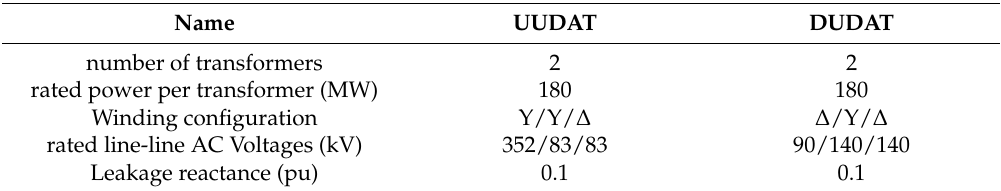
Table 5. Parameters of the AC